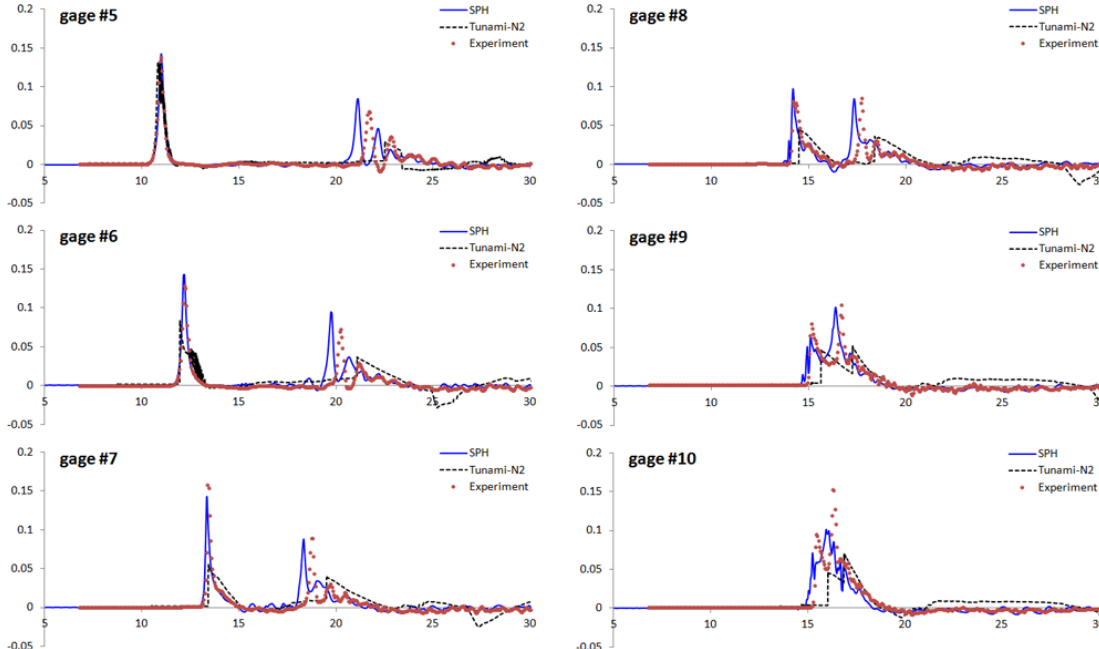
Fig. 9. Comparisons of time histories of wave height obtained from the experiment and numerical simulations at gages 5–10 of case